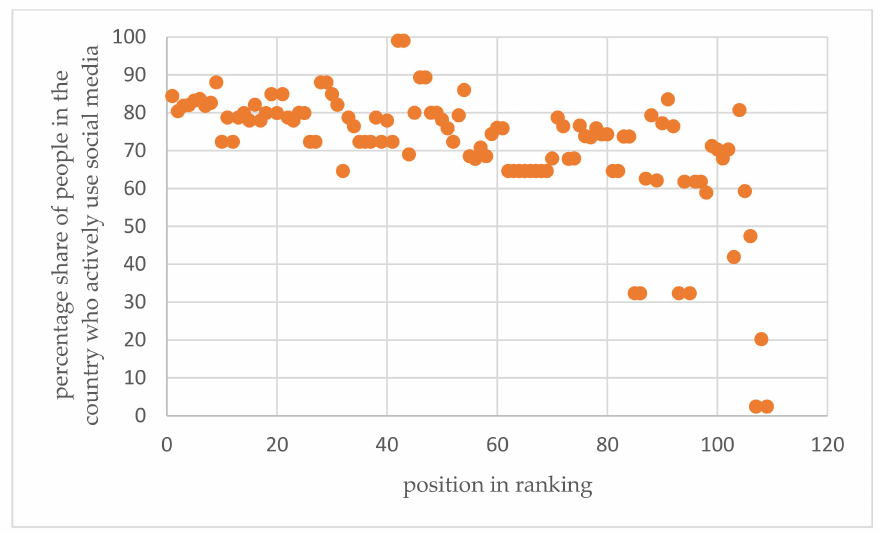
Figure 2. Social media use and the position in the Smart City Index 2020 ranking. Source: author’s work based on [44,54].